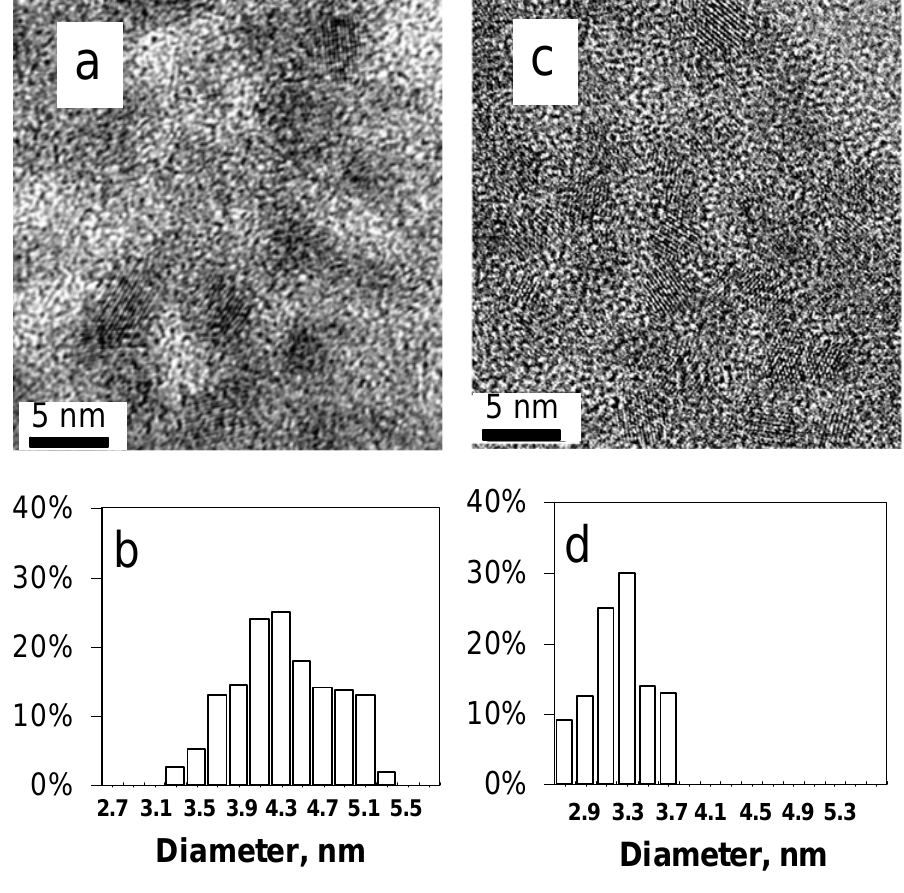
Figure 5. TEM images of SnS nanoparticles synthesized in the presence of ( a ) 2 mL TEA; and ( c ) 4mL TEA at room temperature, respectively. Histograms of particle size distribution for ( b ) SnS nanoparticles made with 2 mL TEA; and ( d ) SnS nanoparticles made with 4 mL